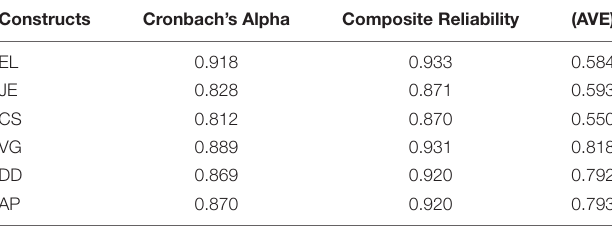
TABLE 1 | Reliability and convergent validity.